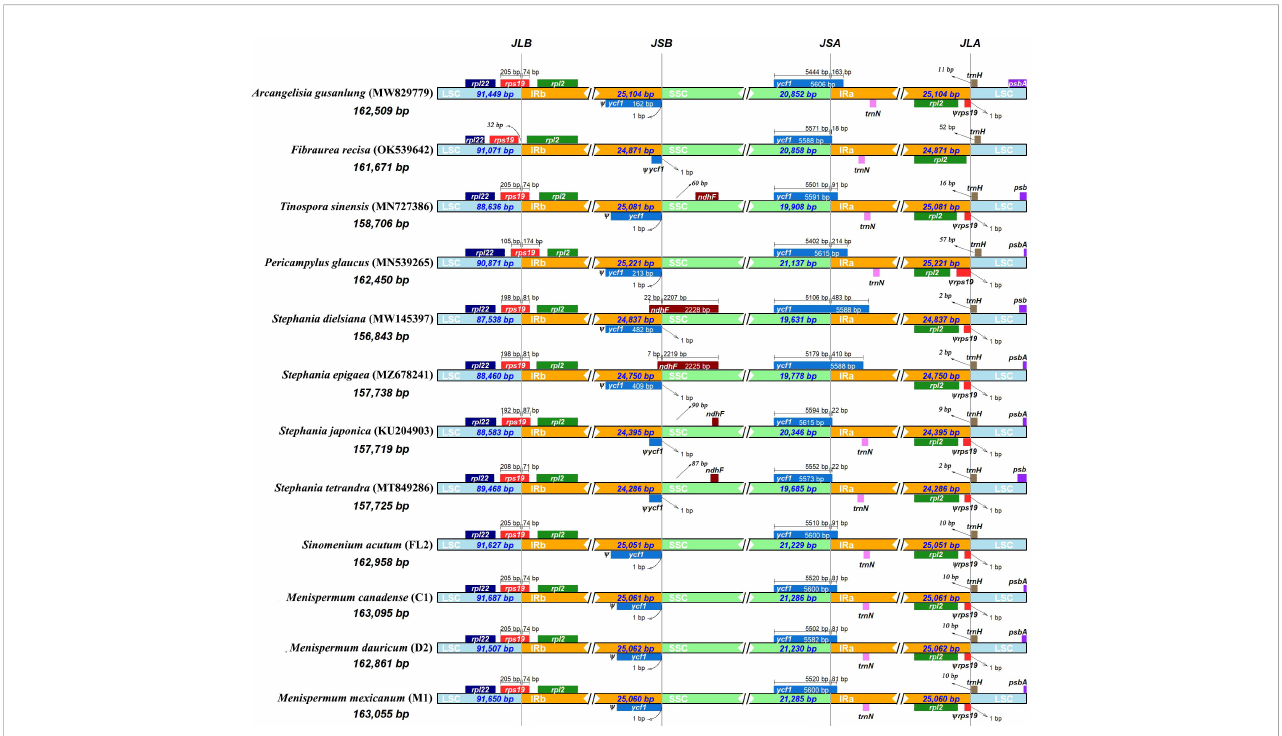
FIGURE 6 Comparison of the LSC/IRb/SSC/IRa junctions among the 12 complete plastomes of Menispermaceae. Sample codes are the same as in Table 1.